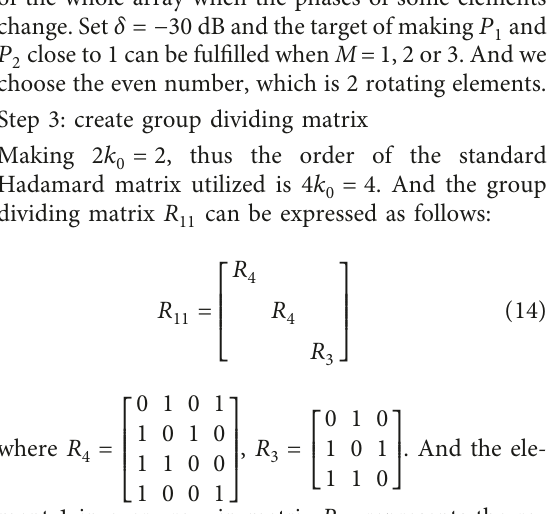
Figure 7: The probability of event1 and event2 while (M) varies.